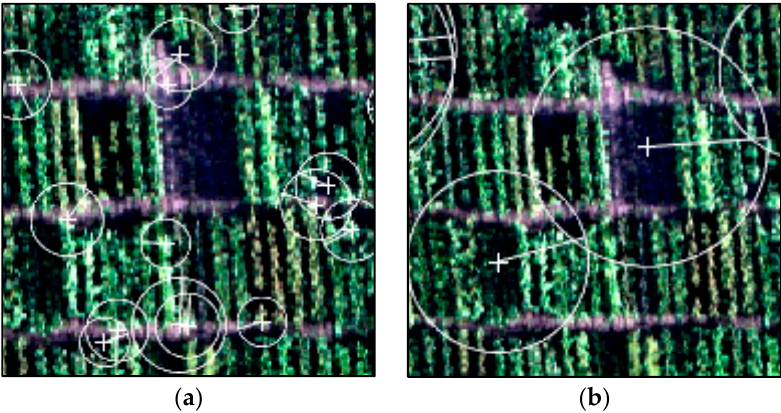
Figure 3. Extracted features over an agricultural field at different scales: ( a ) fine-scale features; and ( b ) coarse-scale features.